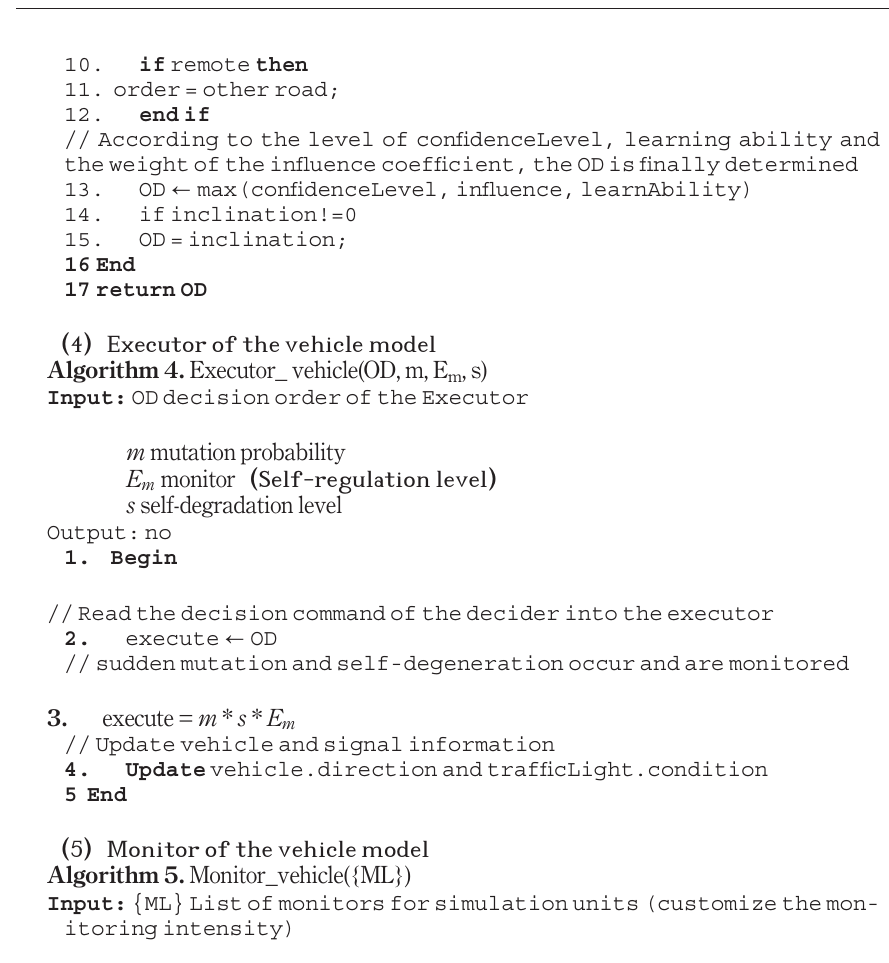
Algorithm 5. Monitor_vehicle({ML})